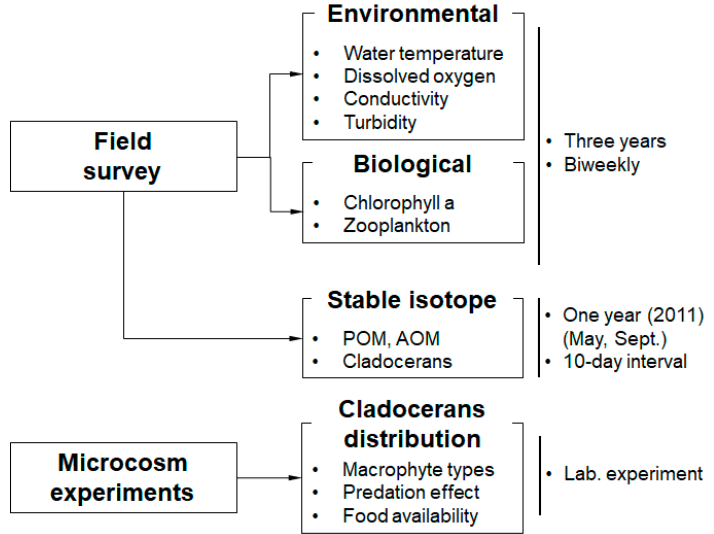
Figure 2. Schematic flowchart of the current study. Particulate organic matter (POM), and attached organic matter (AOM).